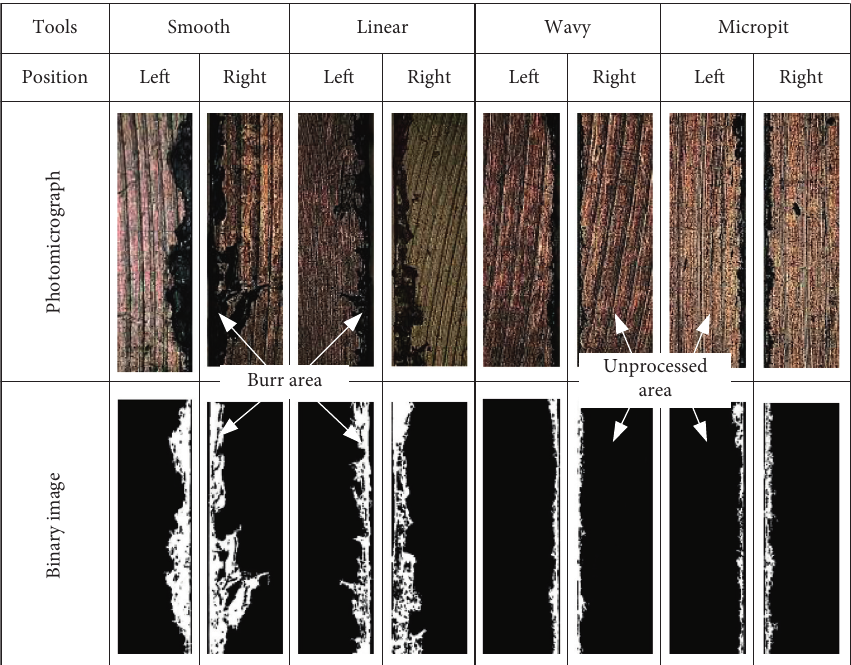
Figure 7: Photomicrographs and binary images of the top-burr of the workpiece under different textured milling tools.